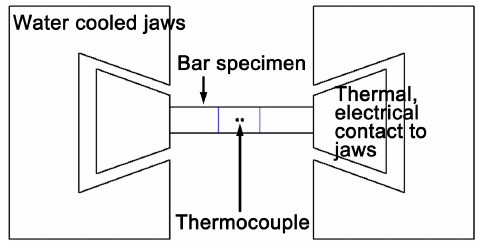
Figure 4. Schematic of the Gleeble simulation specimen of the welding HAZ.